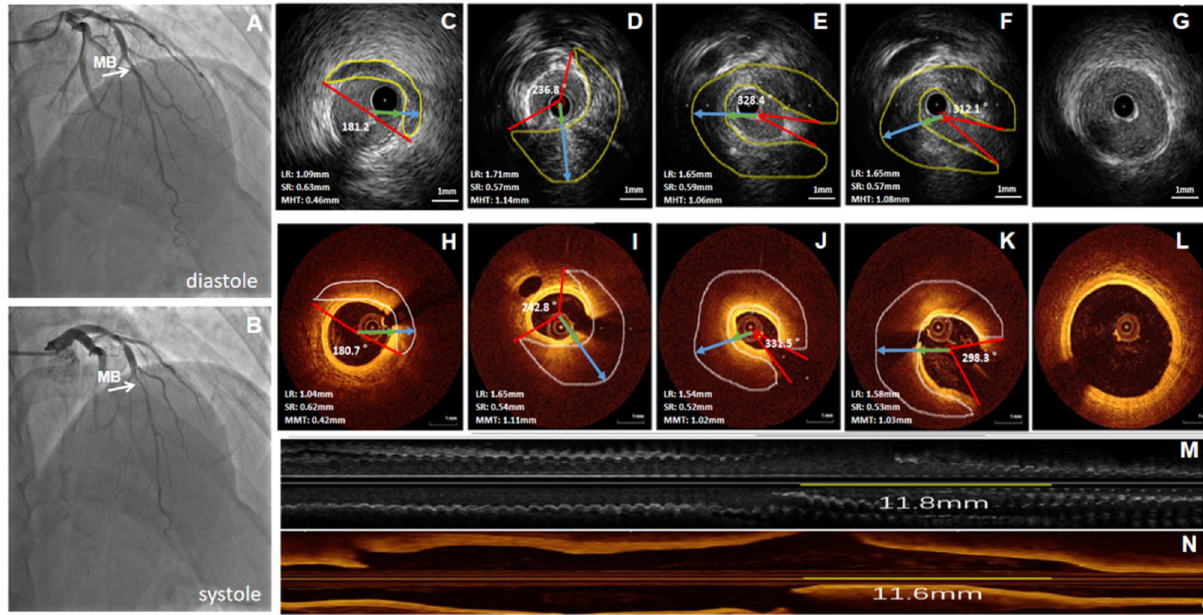
Figure 2. The representative case with MB was shown to measure indexes about the "half-moon" area and the muscle layer around the vessel’s adventitia. The male patient with MB was 53 years old, and LAD was checked with CAG, IVUS, and OCT. ( A , B ) CAG results of MB. MB was located in the middle segment of LAD. The MLD in the MB segment was 2.43 mm during diastole and 0.97 mm during systole, and the compression rate of MB was 60%. ( C – G , M ) IVUS results of MB. ( C ) Showed the MHT was 0.46 mm, and the HA was 181.2°. ( D ) Showed the MHT was 1.14 mm, and the HA was 236.8°. ( E ) Showed the MHT was 1.06 mm, and the HA was 328.4°. ( F ) Showed the MHT was 1.08 mm, and the HA was 312.1°. ( G ) Showed there was no "half-moon" area in the proximal cross-section. ( M ) Showed the total length of the "half-moon" area was 11.8 mm. ( H – L , N ) OCT results of MB. ( H ) Showed the MMT was 0.42 mm, and the MA was 180.7°. ( I ) Showed the MMT was 1.11 mm, and the MA was 242.8°. ( J ) Showed the MMT was 1.02 mm, and the MA was 331.5°. ( K ) Showed the MMT was 1.03 mm, and the MA was 298.3°. ( L ) Showed there was no muscle layer in the proximal cross-section. ( N ) Showed the total length of the muscle layer was 11.6 mm. Scale bar: 1 mm. MB myocardial bridge, LAD left anterior descending artery, CAG coronary angiography, IVUS intravascular ultrasound, OCT optical coherence tomography, MLD minimum lumen diameter, LR long radius, SR short radius, MHT maximal